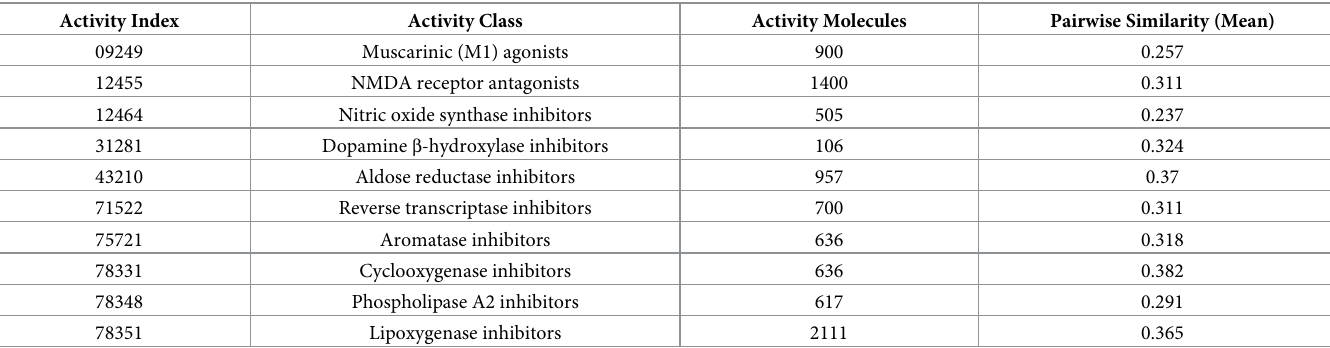
Table 3. Activity class for dataset DS3.